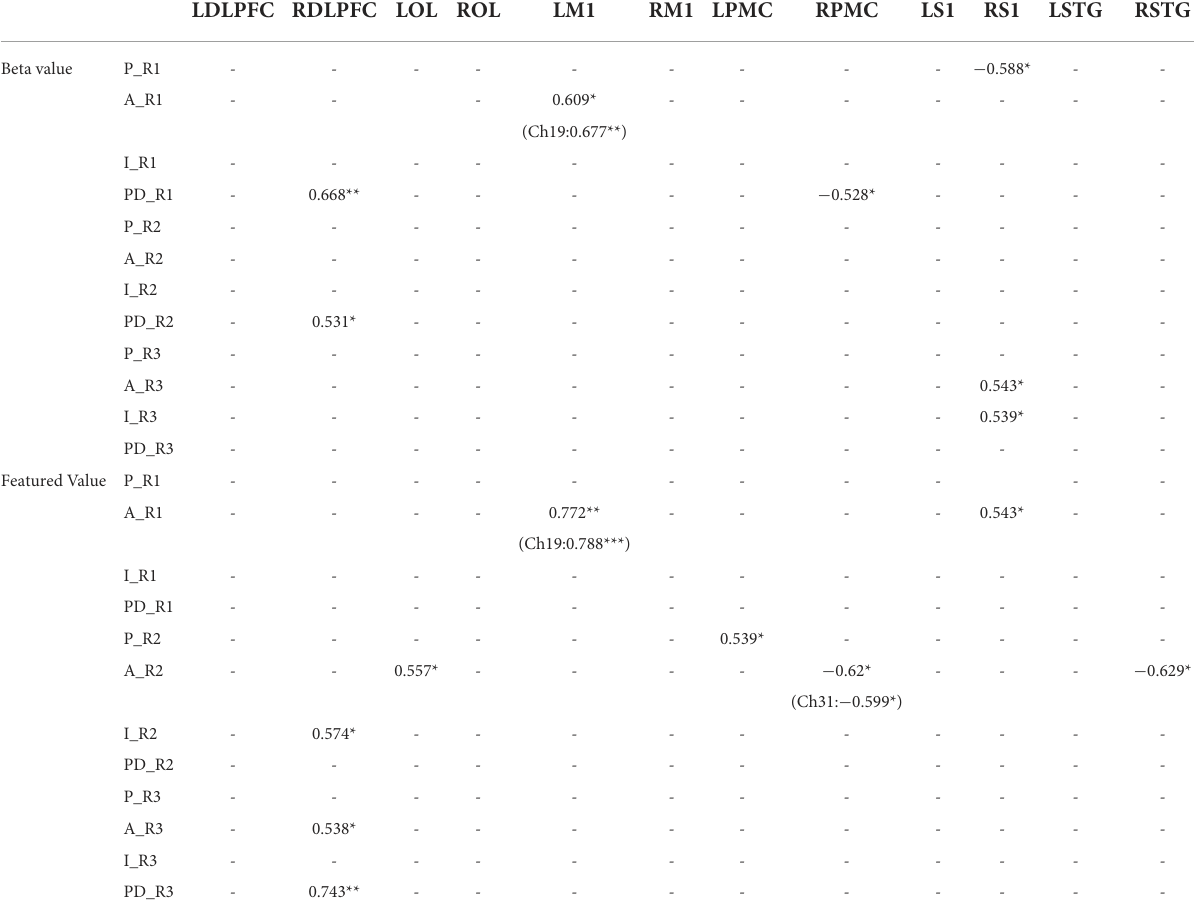
TABLE 3 Spearman’s correlation between virtual reality questionnaire (VRQ) items and cortical activation ( β and featured values).